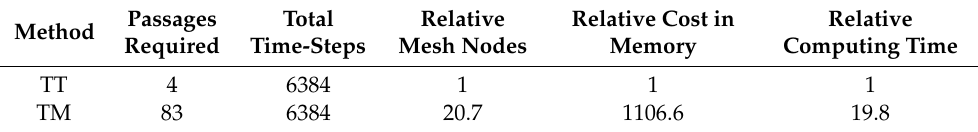
Table 1. Comparison of computational